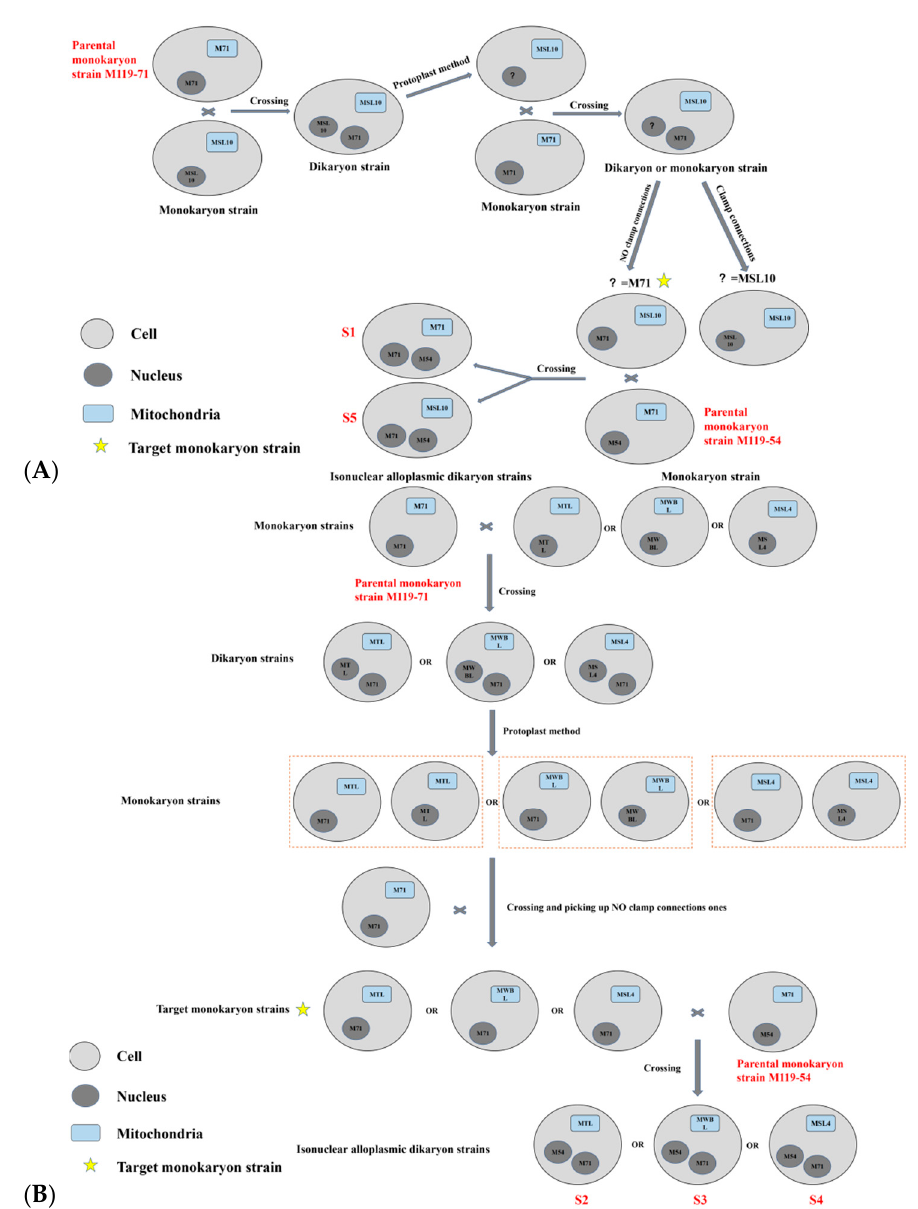
Figure 1. The process of constructing isonuclear alloplasmic. ( A ) The constructed strains S1 and S5. ( B ) The constructed strains S2, S3, and S4. ( B ) The constructed strains S2, S3, and